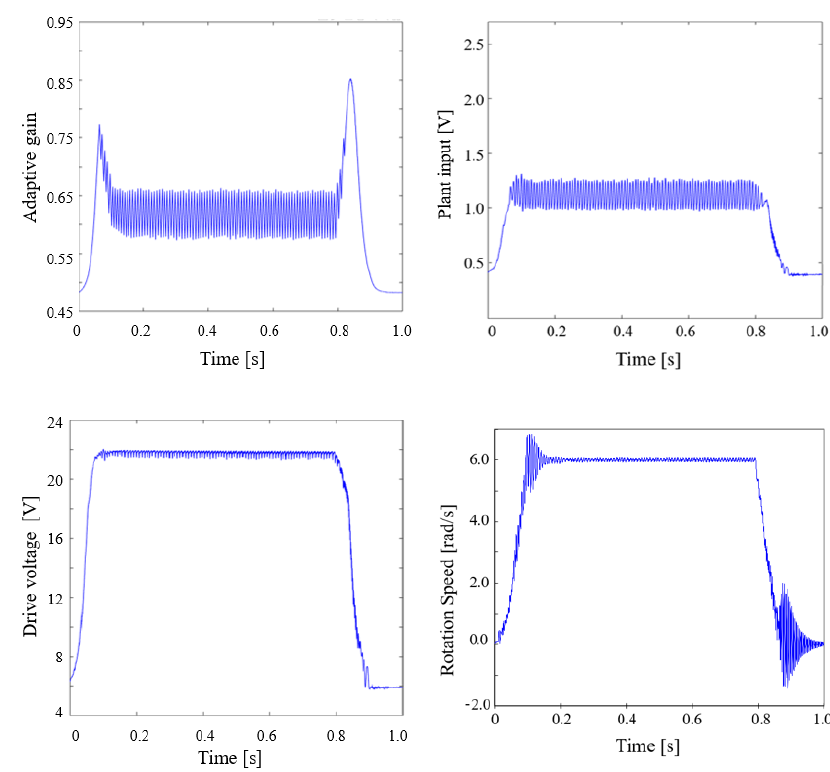
Figure 12. Responses of the proposed method with the PI regulator ( Γ P = 0.5, Γ I = 100). On the other hand, the proposed method with the PI regulator can suppress the chattering of the drive voltage signal occurring with the P regulator and yield a